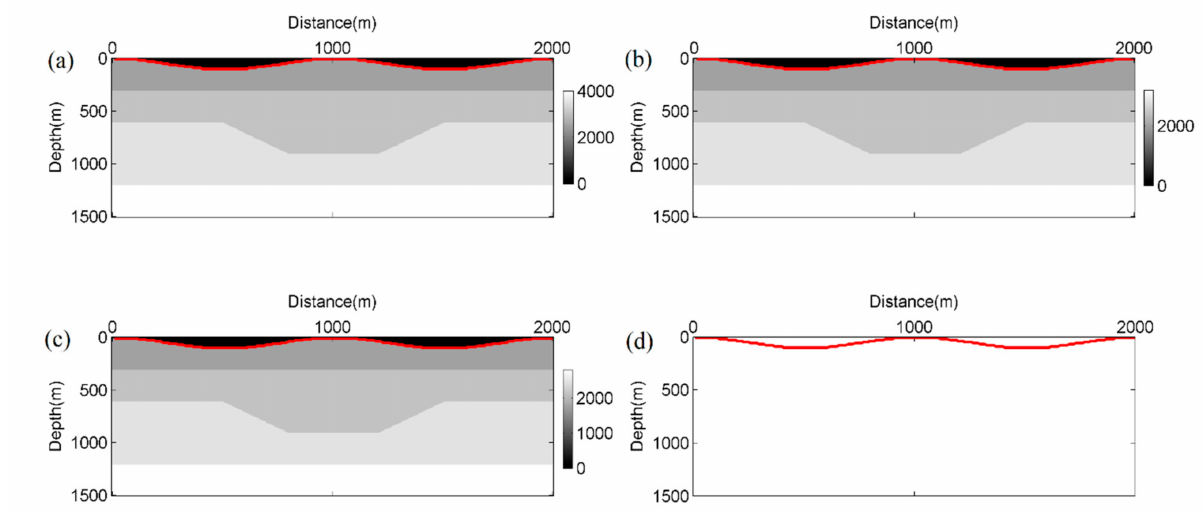
Figure 3. Graben elastic model with a sinusoidal topography: ( a ) V p model, ( b ) V s model, ( c ) ρ model, and ( d ) surface topography of the model. The red line is the surface topography.